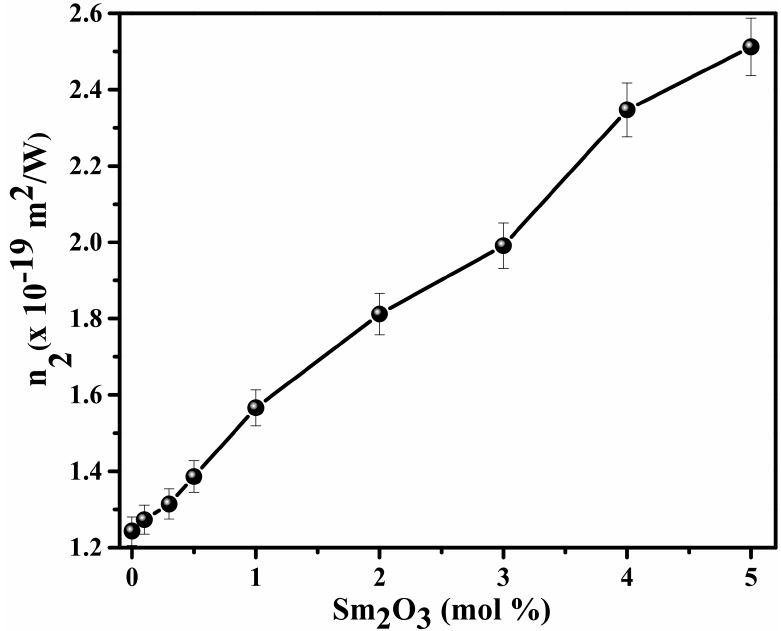
Figure 5. Variation of n2 as the function of Sm 2 O 3 content in the glass